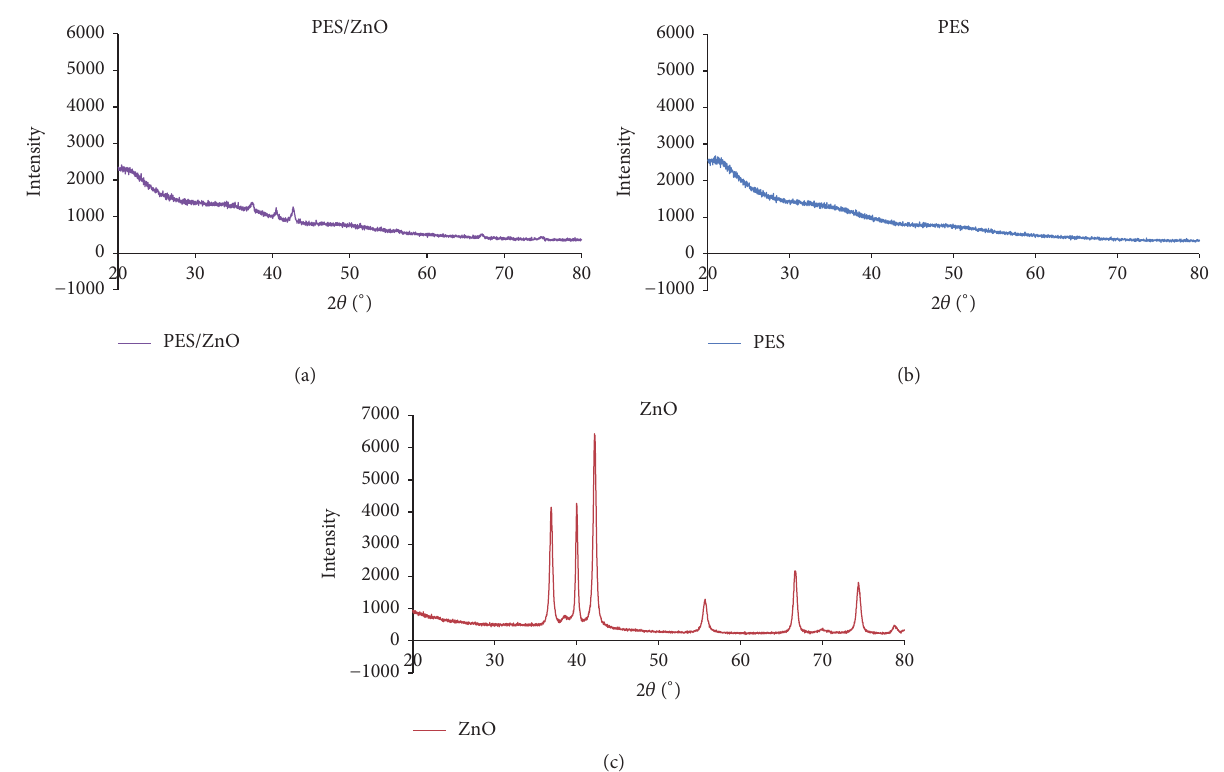
Figure 4: XRD patterns of PES membrane: (a) ZnO/PES composite, (b) pure PES, and (c) ZnO nanoparticles.